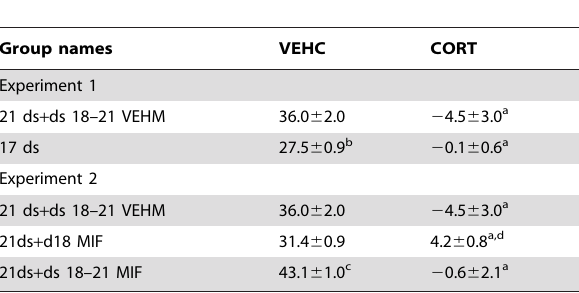
Table 1. Percentual change in body